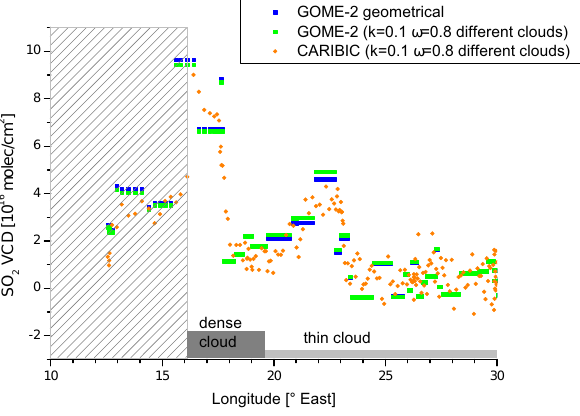
Fig. 15. Comparison of CARIBIC DOAS and GOME-2 SO 2 ver- tical column densities. Besides the standard geometrical AMF for GOME-2, a more appropriate one was simulated, which is based on the cloud and aerosol properties estimated from the CARIBIC DOAS observations. The areas where the different clouds are considered for the AMFs are marked by the grey bars along the x-axes. The hashed area indicates the part of the flight where the Airbus was inside or below the cloud and different air masses are observed by the two instruments.